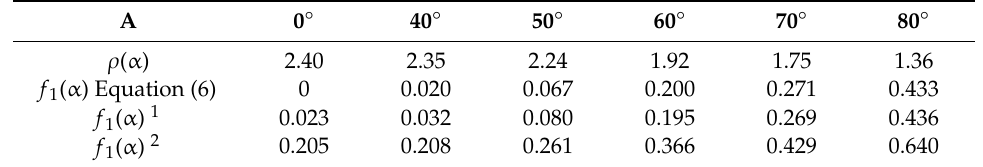
Table 1. Dependencies of the film density ρ (g / cm 3 ) and free volume fraction f 1 on the deposition angle α .